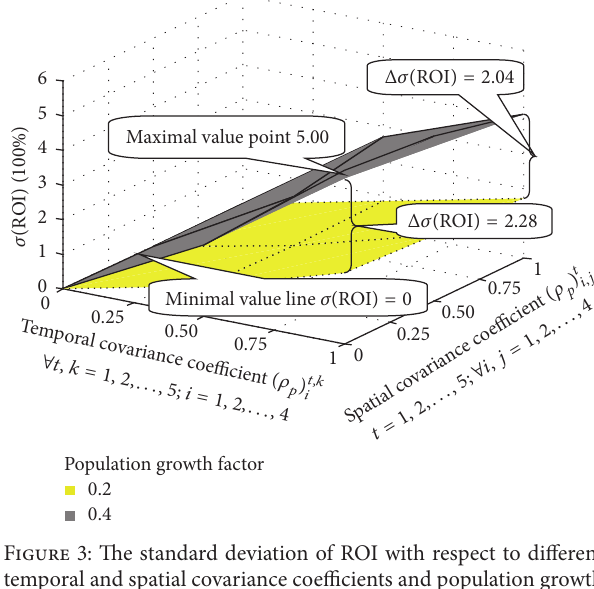
Figure 3: The standard deviation of ROI with respect to different temporal and spatial covariance coefficients and population growth factors over years.